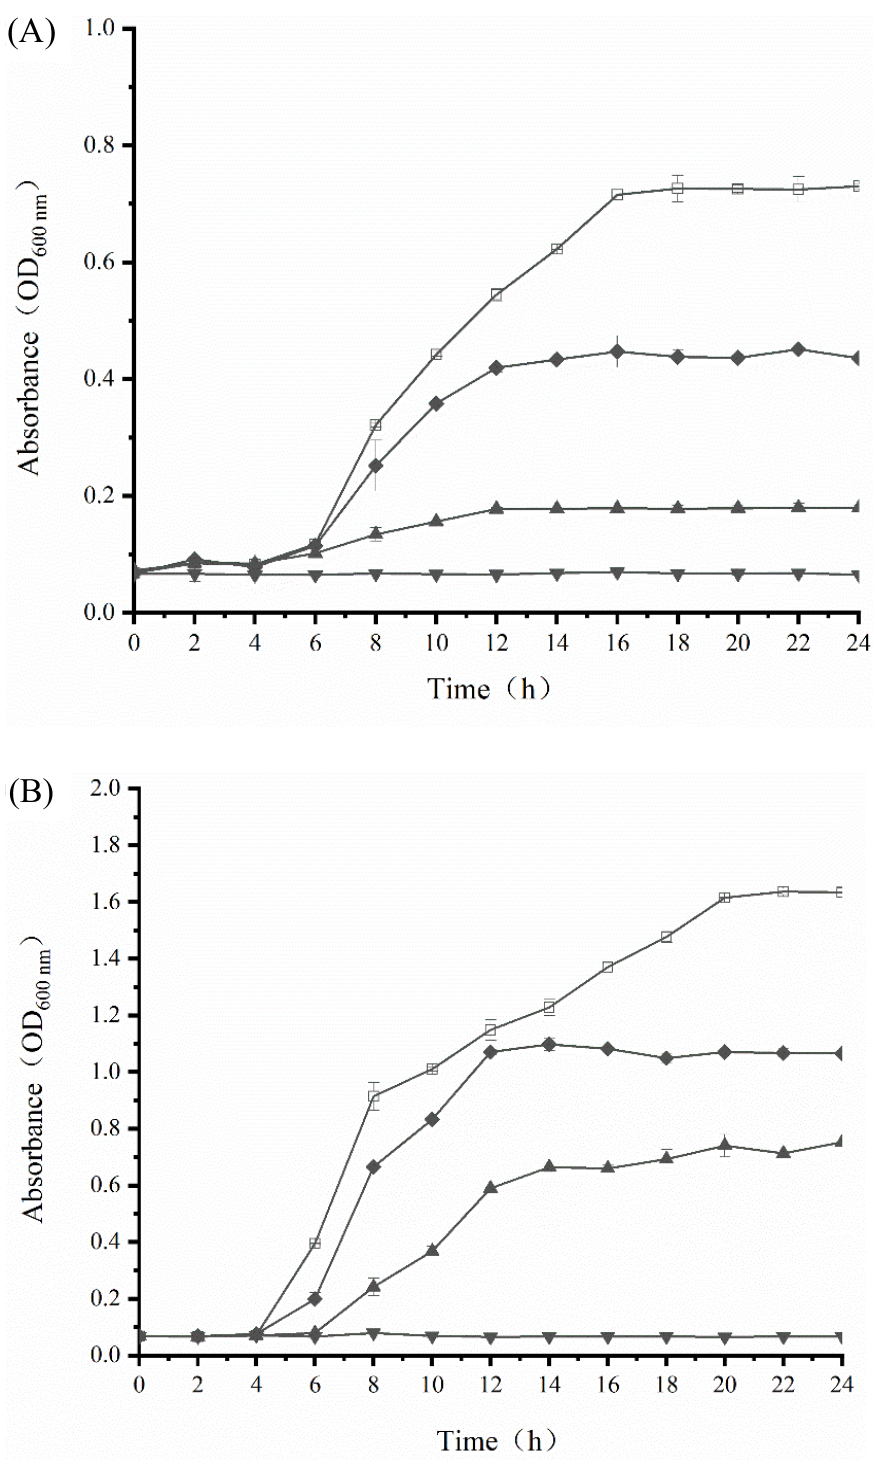
Figure 2. Growth curve of E. coli ( A ) and S. aureus ( B ) during exposure to different concentrations of SAMs in NB at 37 °C for 24 h. The following concentrations of SAMs were used: control ( □ ), 1/4 × MIC ( ◆ ), 1/2 × MIC ( ▲ ), and 1 × MIC ( ▼ ). NB, nutrient broth. Values are displayed as the mean ± standard deviation. Error bars show standard deviations, which have been plotted for all data points. Symbols without visible vertical bars suggest that the symbol size is larger than the standard deviation.